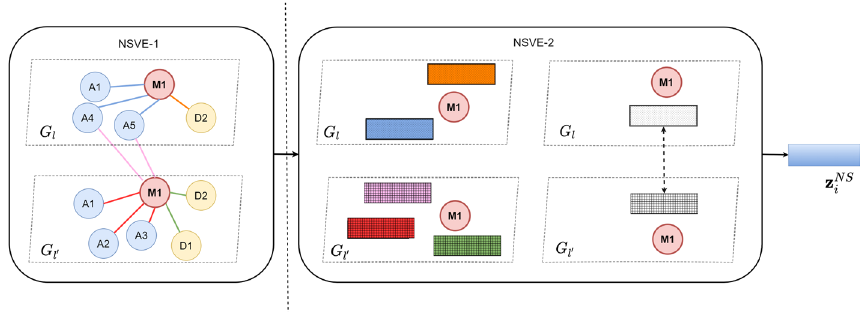
Fig. 5 Illustration of hierarchical attention approach used in the steps of the network schema view embedding (i.e., NSVE-1 and NSVE-2), with focus on the target entity M 1 in different layers. From left to right, NSVE-1 box shows node-level attention w.r.t. target nodes M 1 , with colored lines denoting different relations and matching different attention weights; NSVE-2 box shows type-level attention w.r.t. target nodes M 1 , with different colors, resp. textures, denoting the embeddings obtained from different relations, resp. layers, and across-layer attention w.r.t. target nodes M 1 , combining the embeddings of different